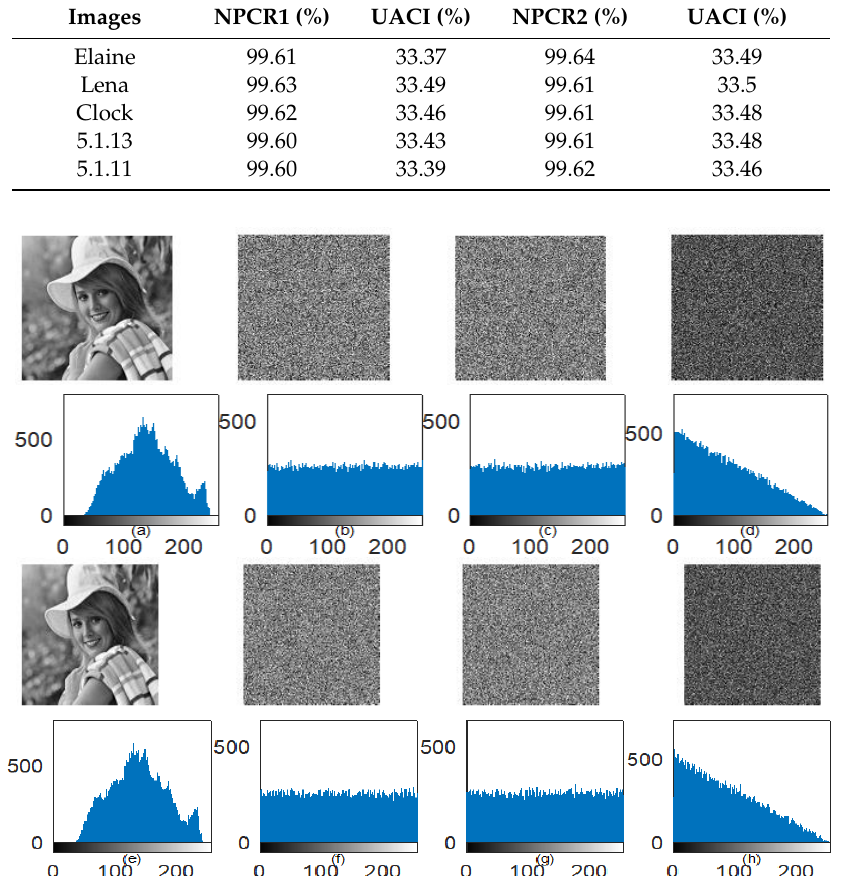
Figure 13. ( a – d ) Encryption sensitivity using the image and its histogram, ( a ) Elaine image; ( b ) Encrypted image using correct secret key; ( c ) Encrypted images using modified secret key; ( d ) Image difference between encrypted images using correct and modified secret key ( e – h ); Decryption sensitivity using an image and its histogram; ( e ) Decrypted images using the correct secret key; ( f – g ) Decrypted images using two different modified secret keys; ( h ) Image difference between decrypted images using two different modified secret keys.